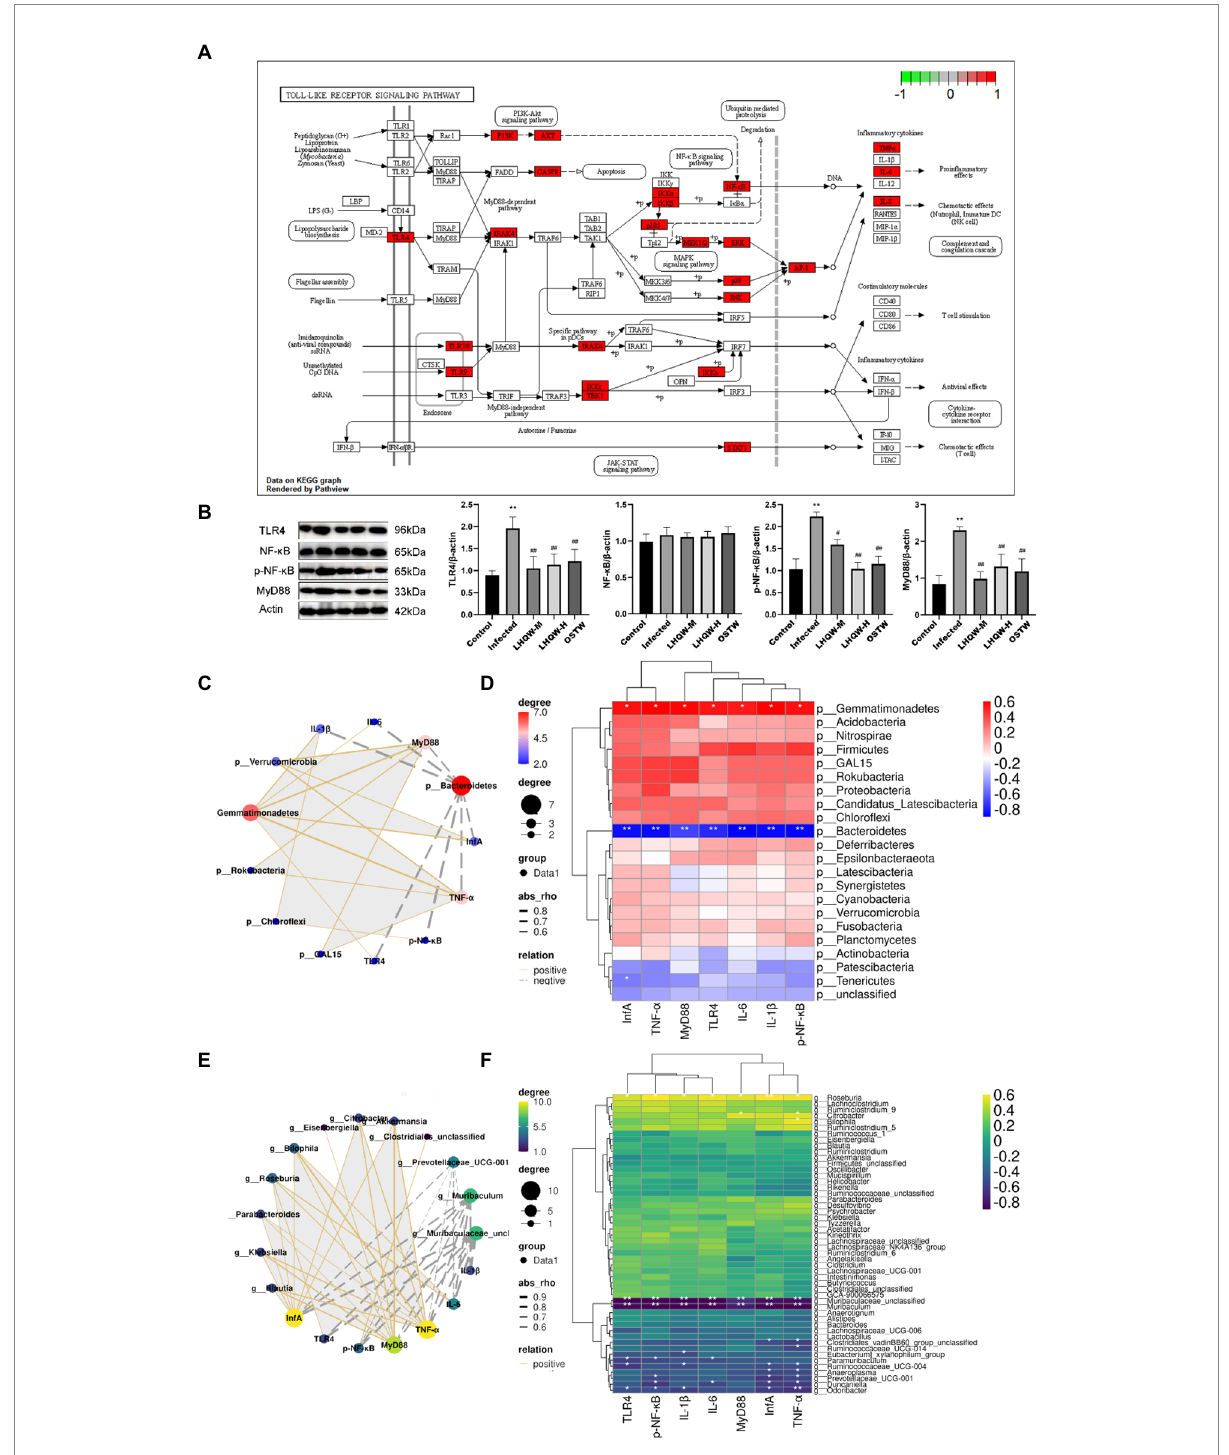
FIGURE 8 Correlation analysis. (A) Toll-like receptor signaling pathway; (B) TLR4, NF- κ B, and p-NF- κ B levels in mouse lung tissue. MyD88 protein expression level; Correlation network diagram (C) and heat diagram (D) at the phylum level; Correlation network diagram (E) and heat map (F) at the genus level. Compared with control group, * p < 0.05, ** p < 0.01; Compared with infected group, # p < 0.05, ## p < 0.01.